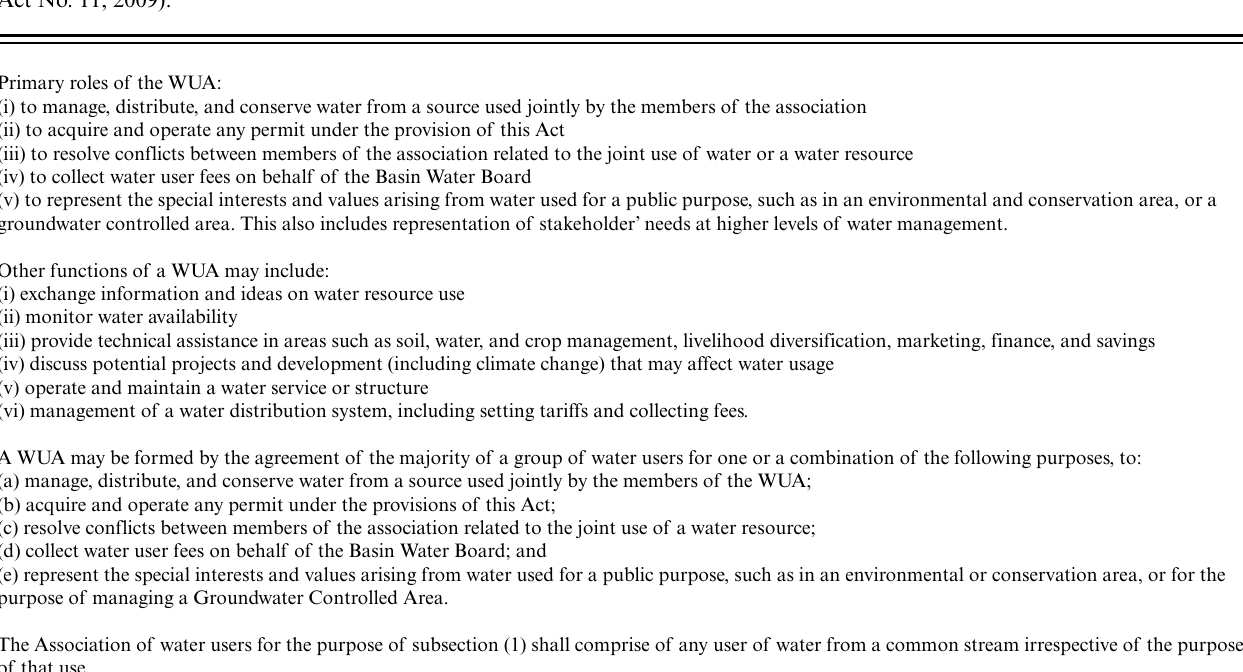
Table 2. Roles and responsibilities of water users’ associations (WUAs) in Tanzania (Source: Tanzania Water Resources Management Act No. 11,